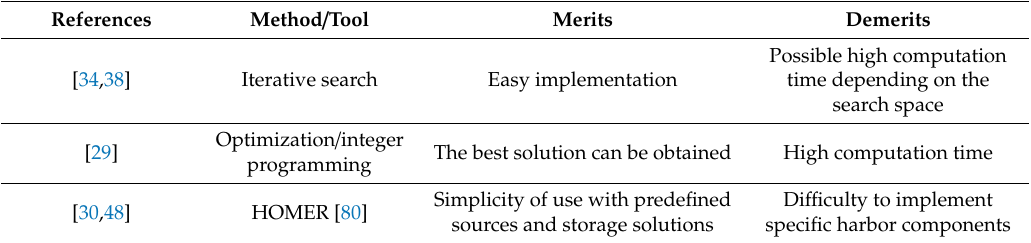
Table 2. Methods and tools used in articles dealing with the sizing of harbor